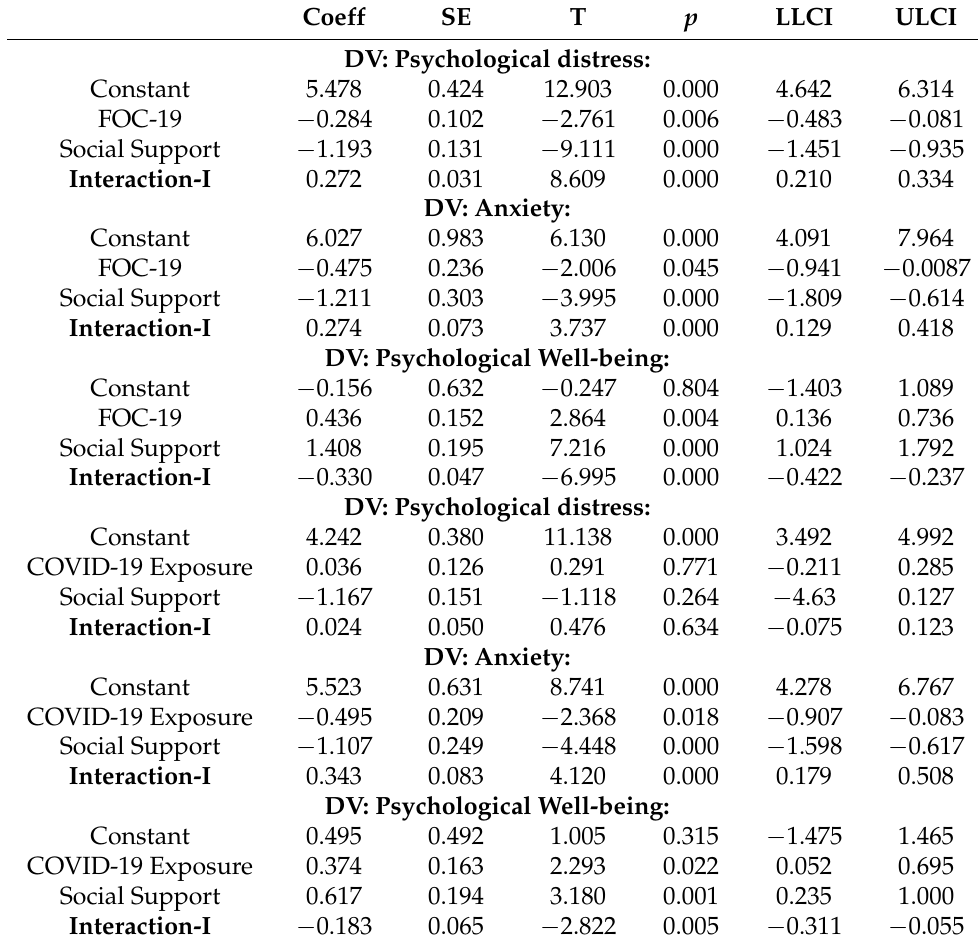
Table 5. Moderating effects of Social